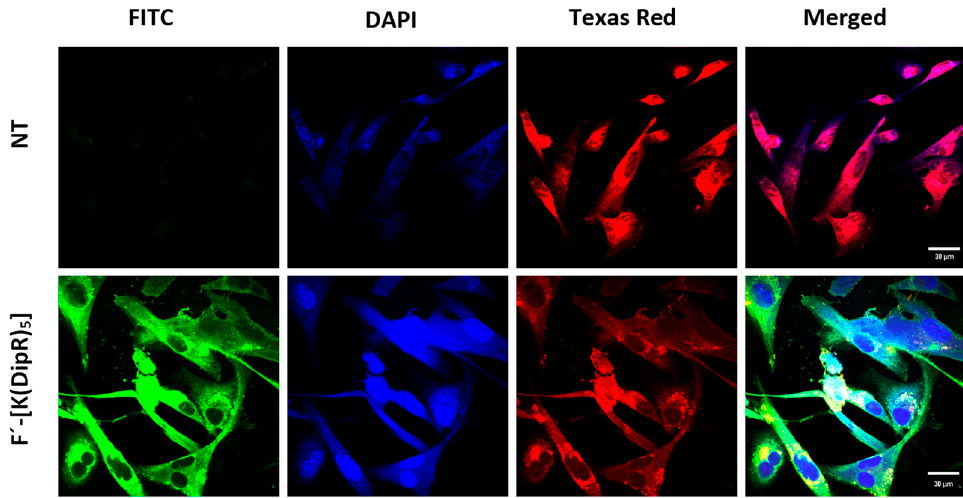
Figure 14. The confocal microscopy images of F’-[K(DipR) 5 ] (10 µM) after incubation for 3 h with MDA-MB-231. (NT = No Treatment). Videos of the images are available in supplementary materials. As described in flow cytometry studies above, the uptake of F’-[K(DipR) 5 ] was not completely blocked by endocytosis inhibitors. The confocal microscopy studies of F’- [K(DipR) 5 ] was conducted in the presence of endocytosis inhibitors, which are nystatin,